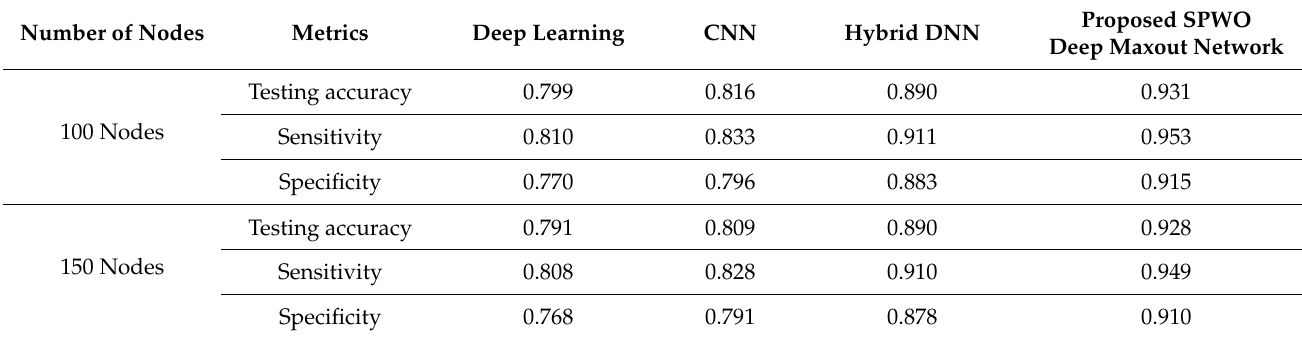
Table 13. Comparison of roposed model with existing